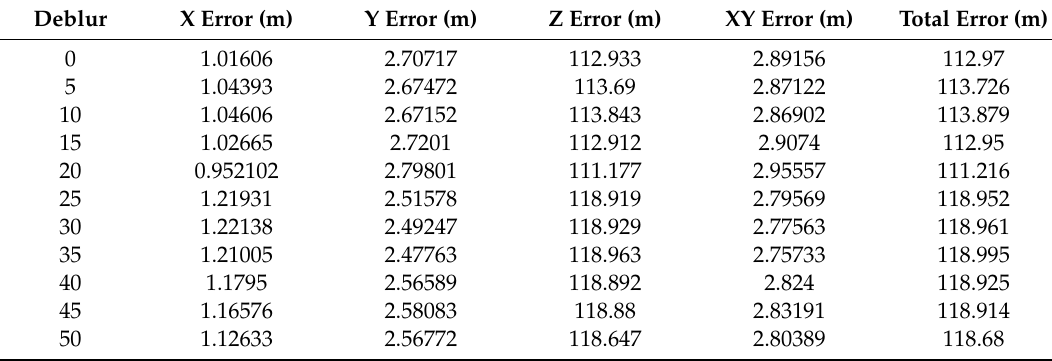
Table 7. Average camera location error (X—Easting, Y—Northing,